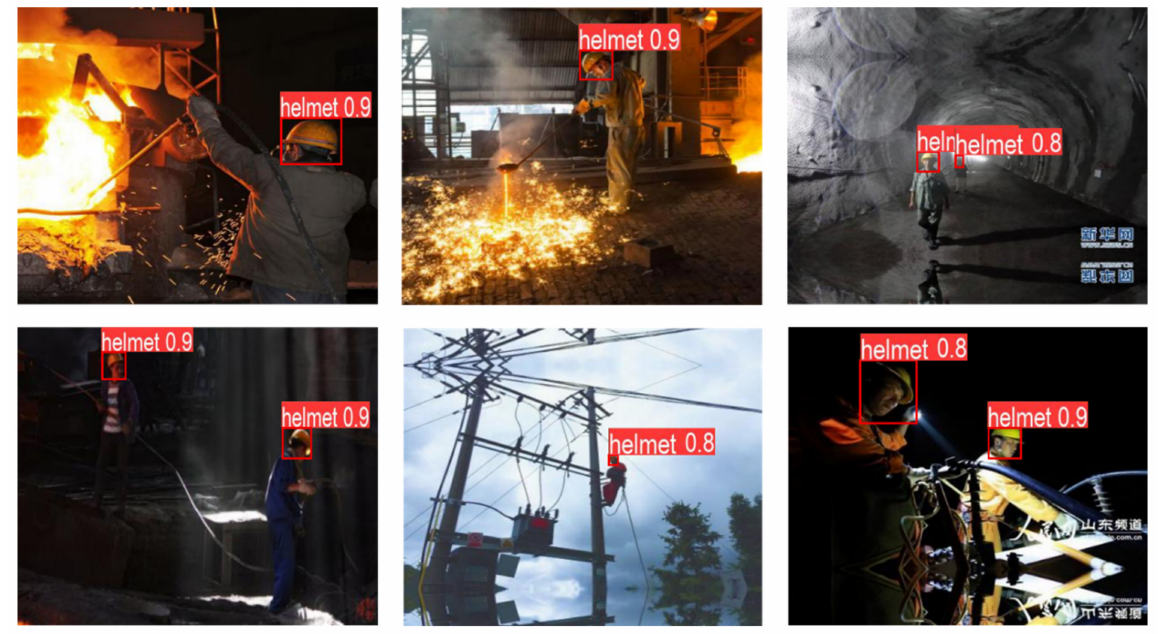
Figure 10. Prediction results of the YOLOv5x model in low-light conditions.